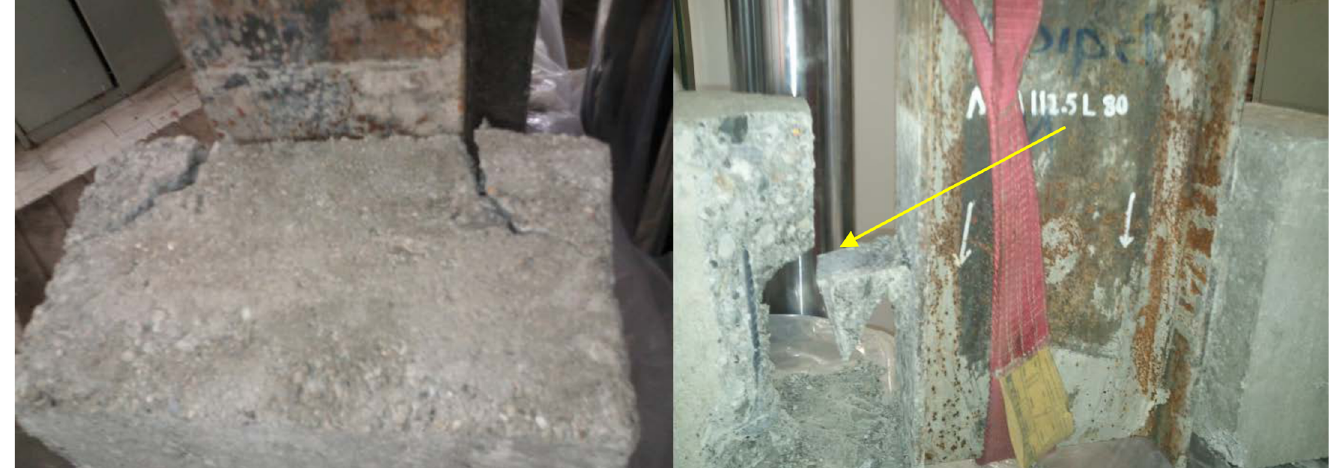
Fig 5. Typical concrete crushing-splitting mode of failure